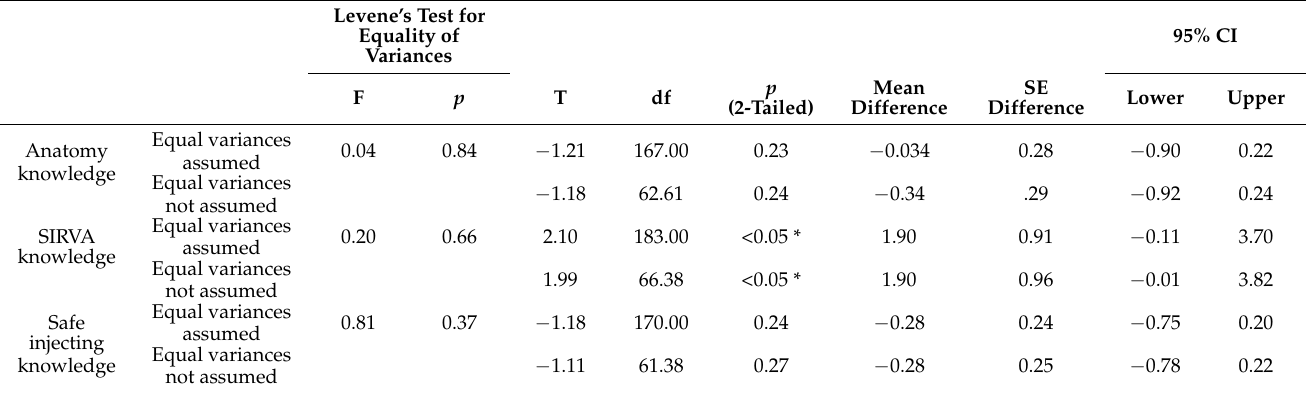
Table A4. Independent T-Test comparing fully qualified professionals and students.